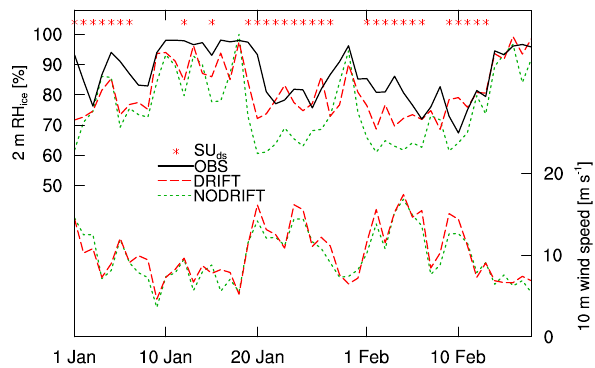
Fig. 3. Relative humidity with respect to ice at 2 m in January and February 2009 at the location of AWS S9. Observed RH ice is drawn in black, the RACMO2 simulation without drifting snow (from Ettema et al., 2010a) in green and RACMO2 with drifting snow in red. The red crosses at the top indicate when SU ds occurs in RACMO2.